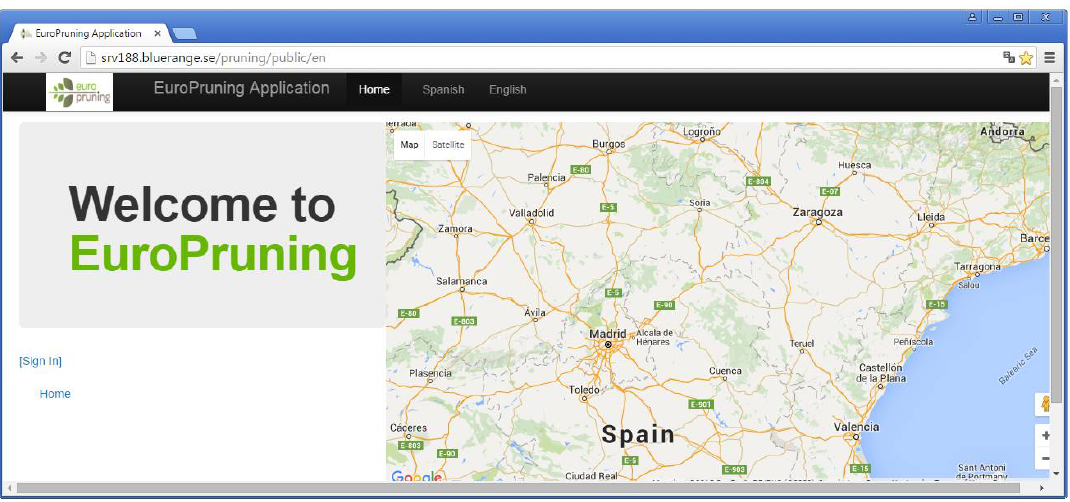
Figure 6. SLS Information platform displaying home page for signing in. http://europruning.mobitron.se/public/en.